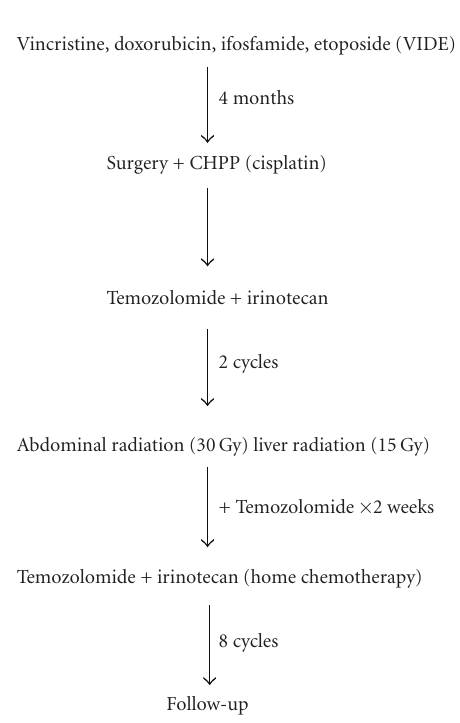
Figure 2: Outpatient neoadjuvant and adjuvant chemotherapy plan for DSRCT . After initial diagnosis and treatment of peritoneal, abdominal and pelvic disease, systemic chemotherapy agents were administered on an outpatient basis followed by local control with cytoreductive surgery + CHPP with cisplatin, then whole abdomen radiation with temozolomide as a radiation sensitizer, followed by temozolomide and irinotecan. Outpatient therapy was 15